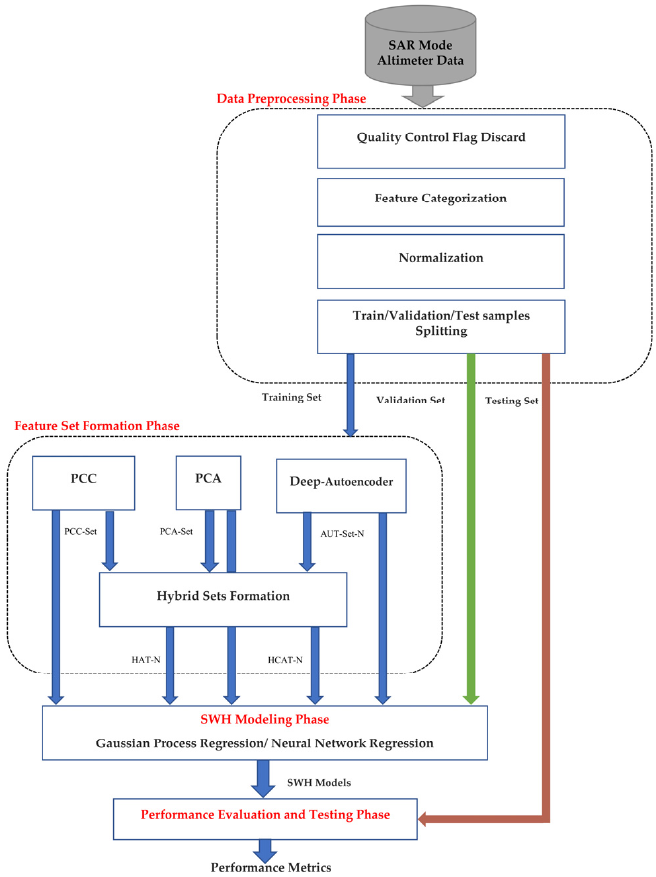
Figure 1. Proposed framework of the current study.